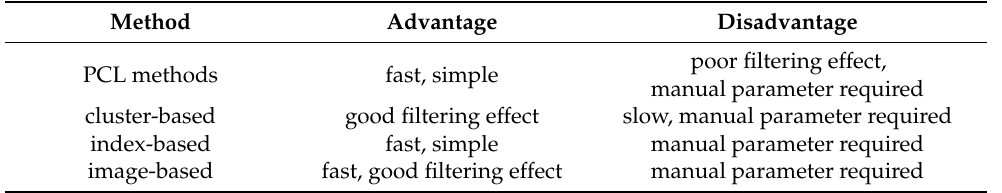
Table 1. Features of various large-scale noise filtering